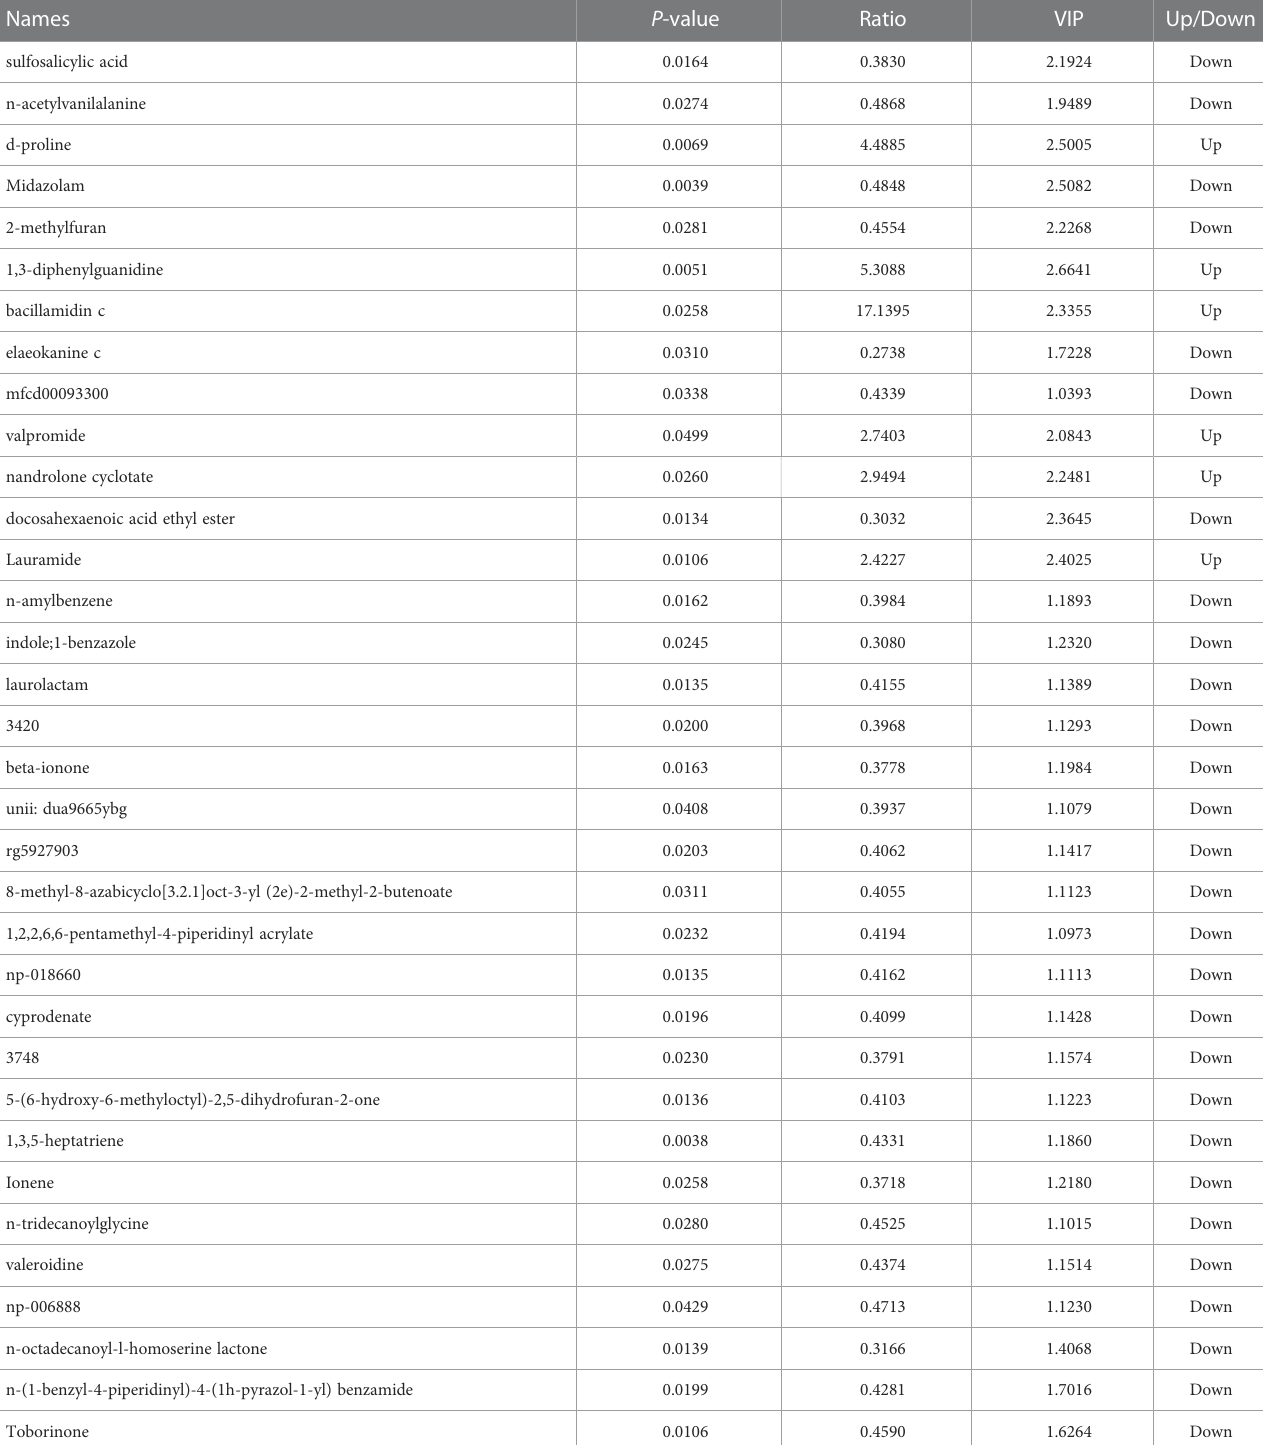
TABLE 4 Differential metabolites (p < 0.05).